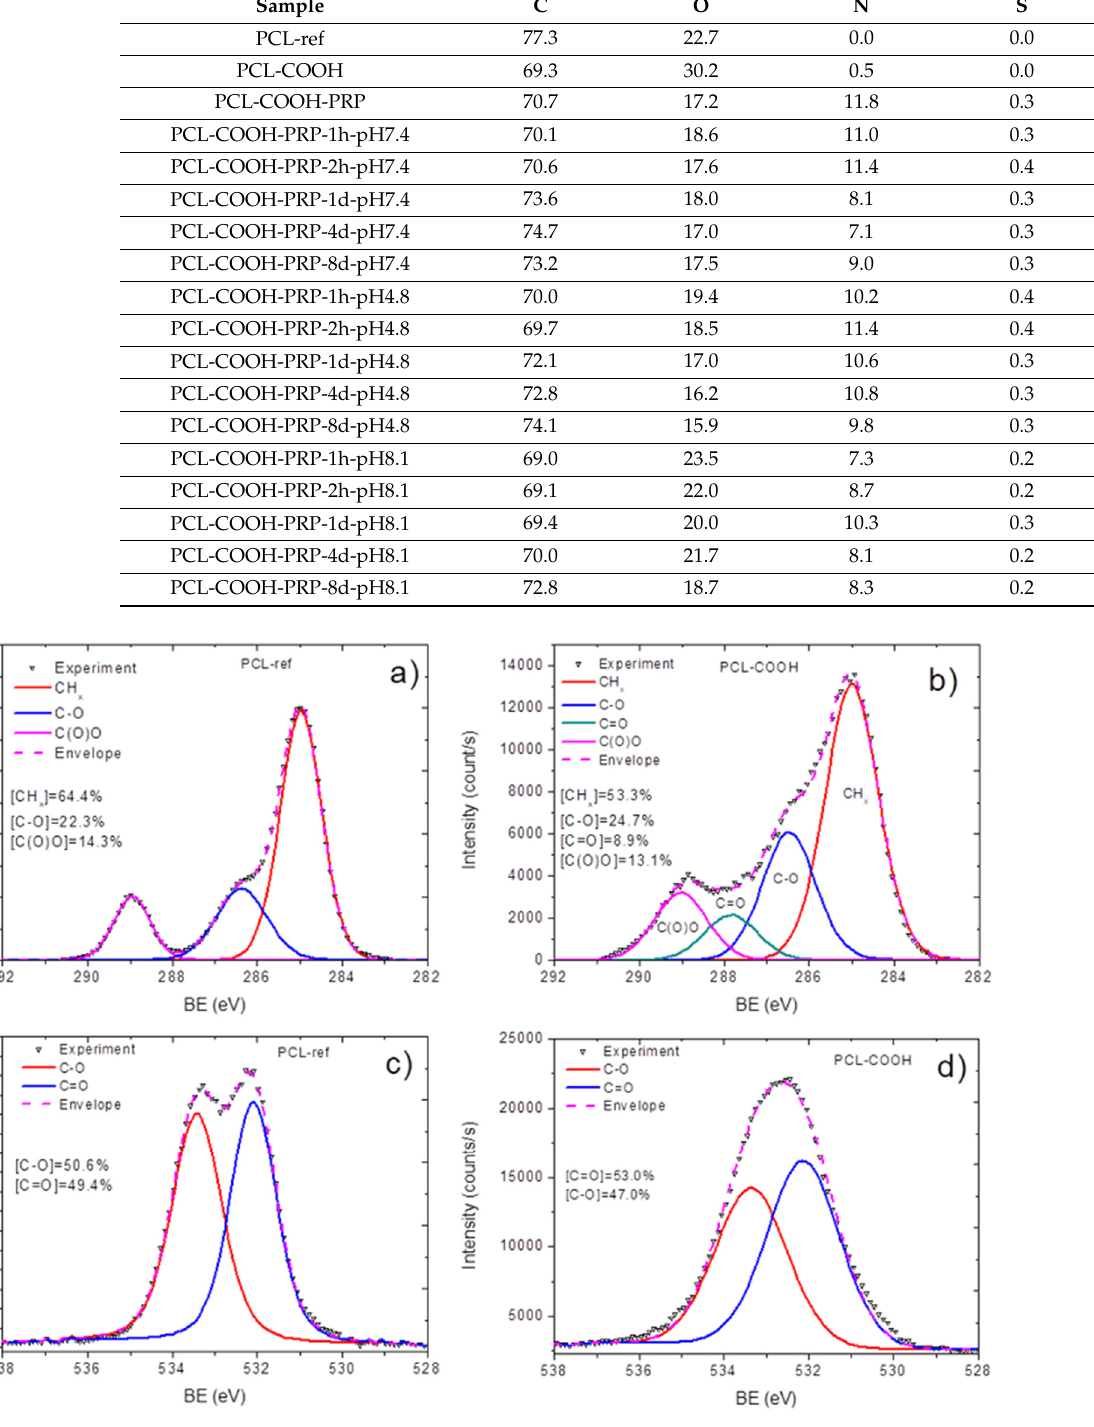
Figure 2. XPS C1s and O1s spectra of the samples: C1s curve fittings of as-prepared nanofibers PCL-ref ( a ) and plasma-modified nanofibers PCL-COOH ( b ); O1s curve fittings of as-prepared nanofibers PCL-ref ( c ) and plasma-modified nanofibers PCL-COOH ( d ).